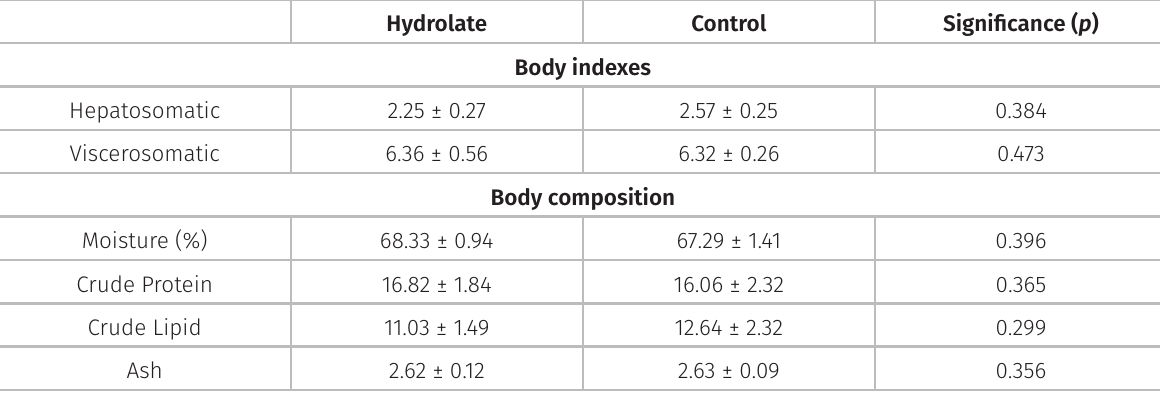
Table III. Body analyses of Nile tilapia ( Oreochromis niloticus ) fed a supplemented hydrolate diet from Curcuma longa .